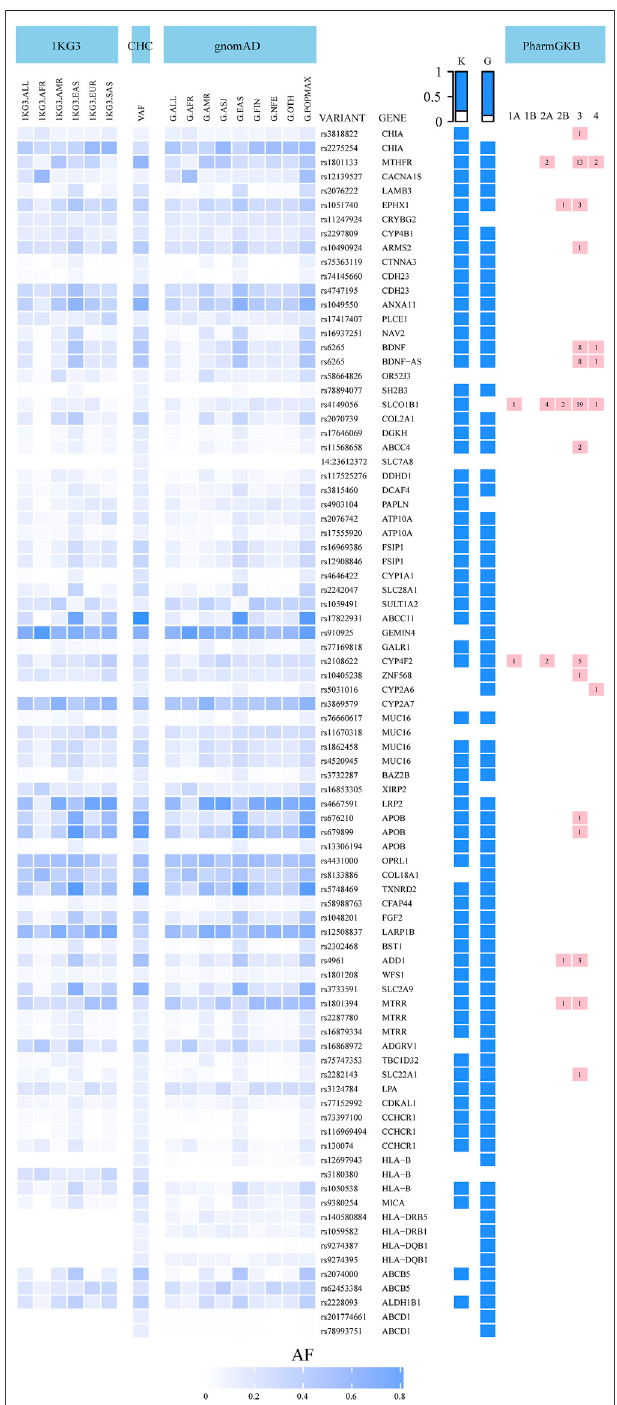
FIGURE 2 | frequency (q < 0.05), the last column represents the number of clinical annotations at various levels of evidence of 16 variants in the PharmGKB. CHC: central Han Chinese population; VAF: variant allele